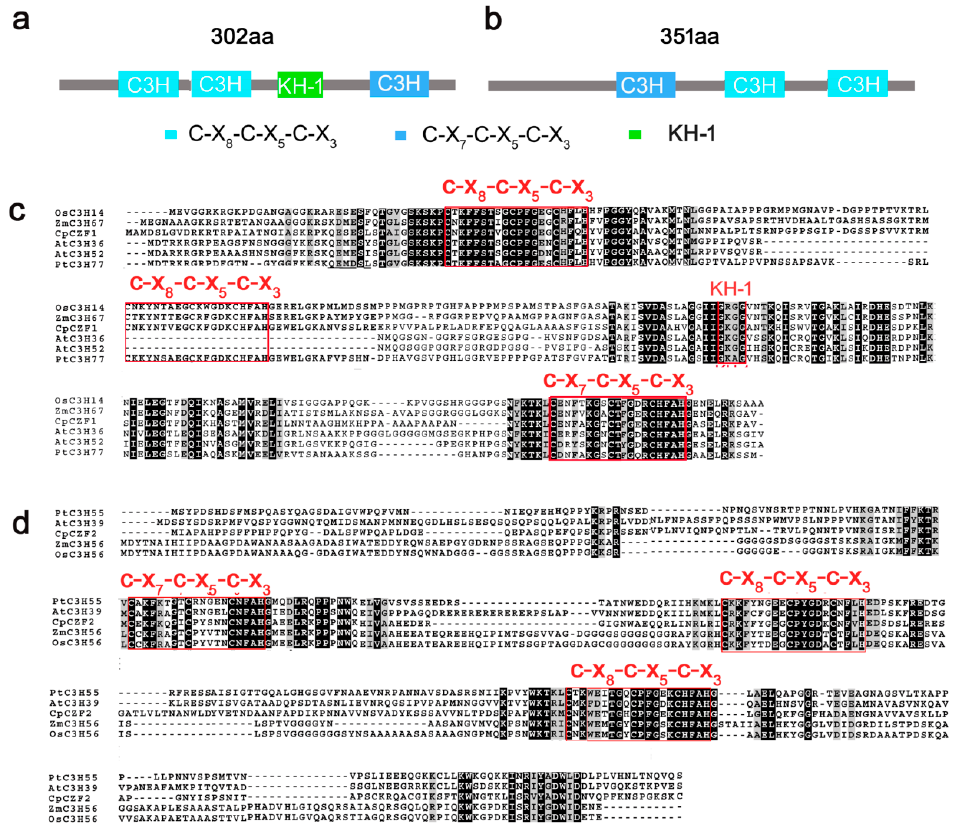
Figure 1. Sequence analysis of CpCZF1 and CpCZF2. Schematic diagrams of protein CpCZF1 ( a ) and CpCZF2 ( b ) . Multiple Sequence Alignment of CpCZF1 ( c ), CpCZF2 ( d ), and their orthologs from Populus trichocarpa , Arabidopsis , Zea mays , and Oryza sativa , respectively . The boxes in blue indicate the C-X 7 -C-X 5 -C-X 3 -H type motif; the boxes in sky-blue indicate the C-X 8 -C-X 5 -C-X 3 -H type motif; the green box indicates the KH-1 domain which is a RNA or single stranded DNA biding domain. The red box indicates the positions of the conserved